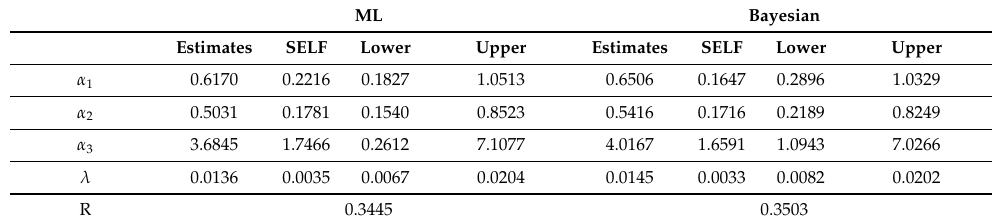
Table 7. ML and Bayesian estimates for stress–strength model based on complete sample.